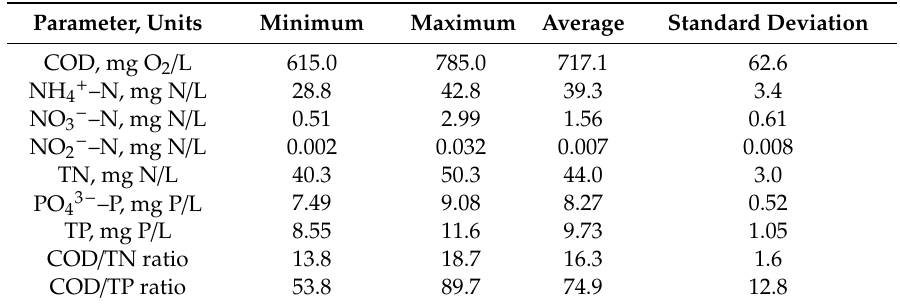
Table 4. Characteristics of wastewater used in this study.